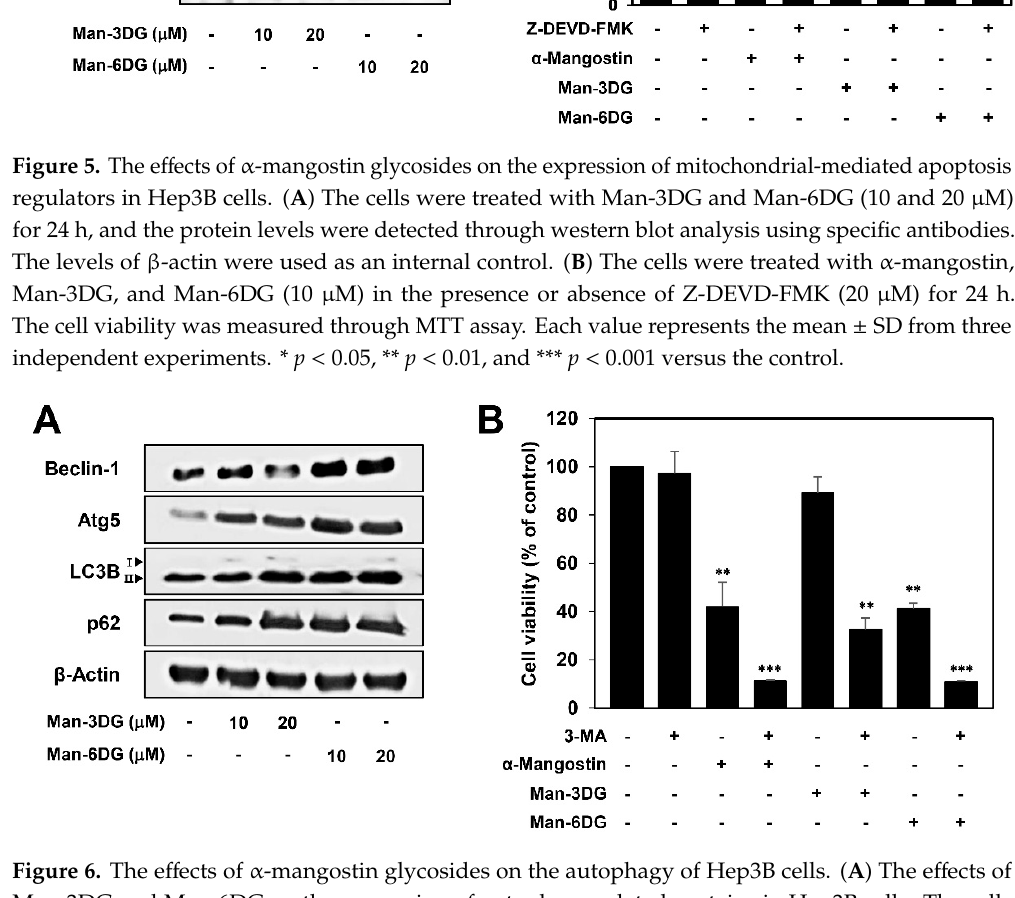
Figure 5. The effects of α -mangostin glycosides on the expression of mitochondrial-mediated apoptosis regulators in Hep3B cells. ( A ) The cells were treated with Man-3DG and Man-6DG (10 and 20 μ M) for 24 h, and the protein levels were detected through western blot analysis using specific antibodies. The levels of β -actin were used as an internal control. ( B ) The cells were treated with α - mangostin, Man-3DG, and Man-6DG (10 μ M) in the presence or absence of Z-DEVD-FMK (20 μ M) for 24 h. The cell viability was measured through MTT assay. Each value represents the mean ± SD from three independent experiments. * p < 0.05, ** p < 0.01, and *** p < 0.001 versus the control.